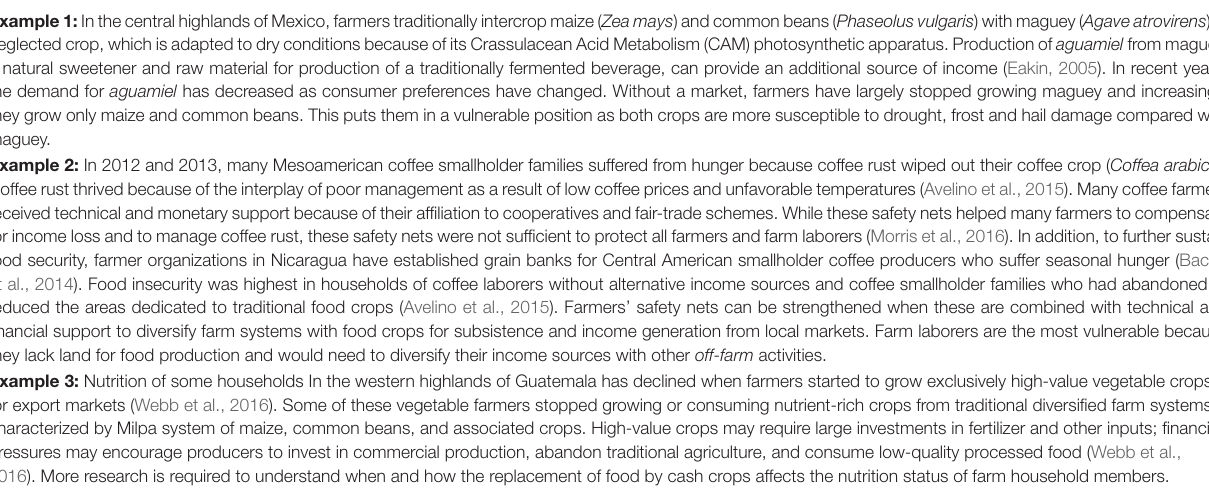
TABLE 3 | Examples of on-farm diversification constraints related to market